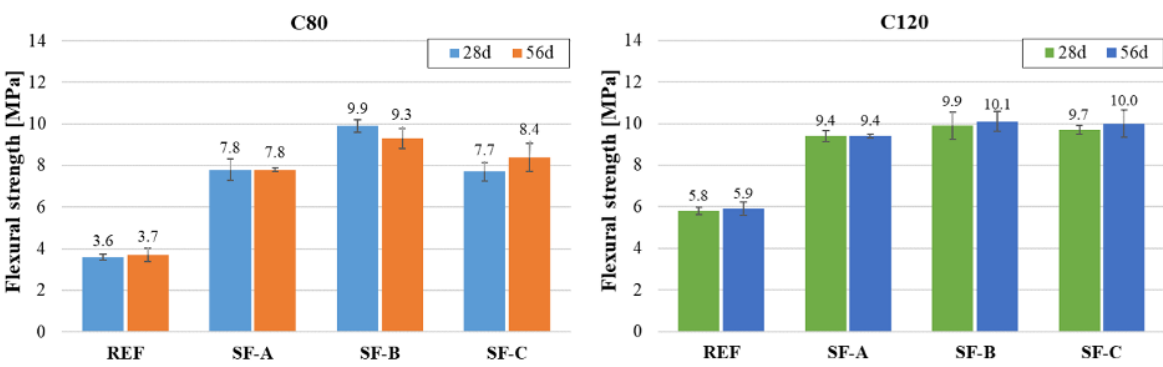
Figure 4. Average flexural strength of C120 and C80 depending on the di ff erent fiber variants.